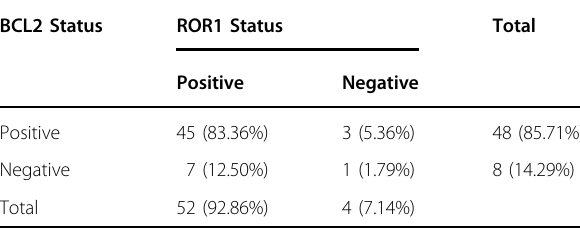
Table 1 BCL2 and ROR1 expression in SCLC IHC